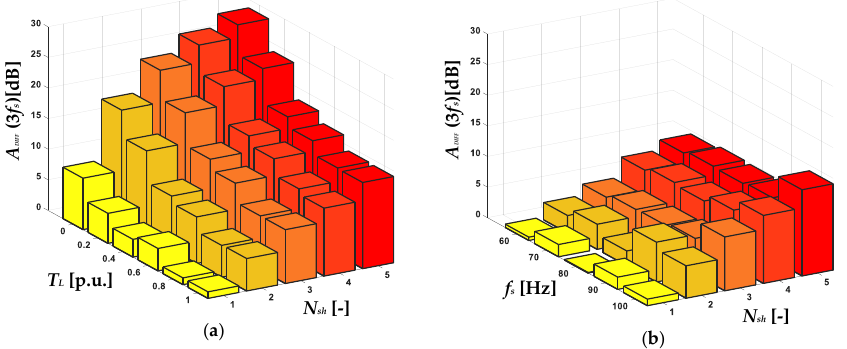
Figure 11. The impact of N sh in the PMSM stator winding and ( a ) T L and ( b ) f s value on the increase in amplitude of 3 f s frequency component in the STFT spectrogram of the positive sequence component of the stator phase currents.